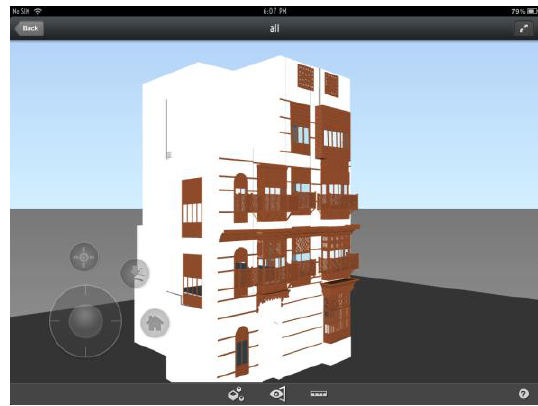
Figure 11. Ground floor Outline plan from JHBIM.